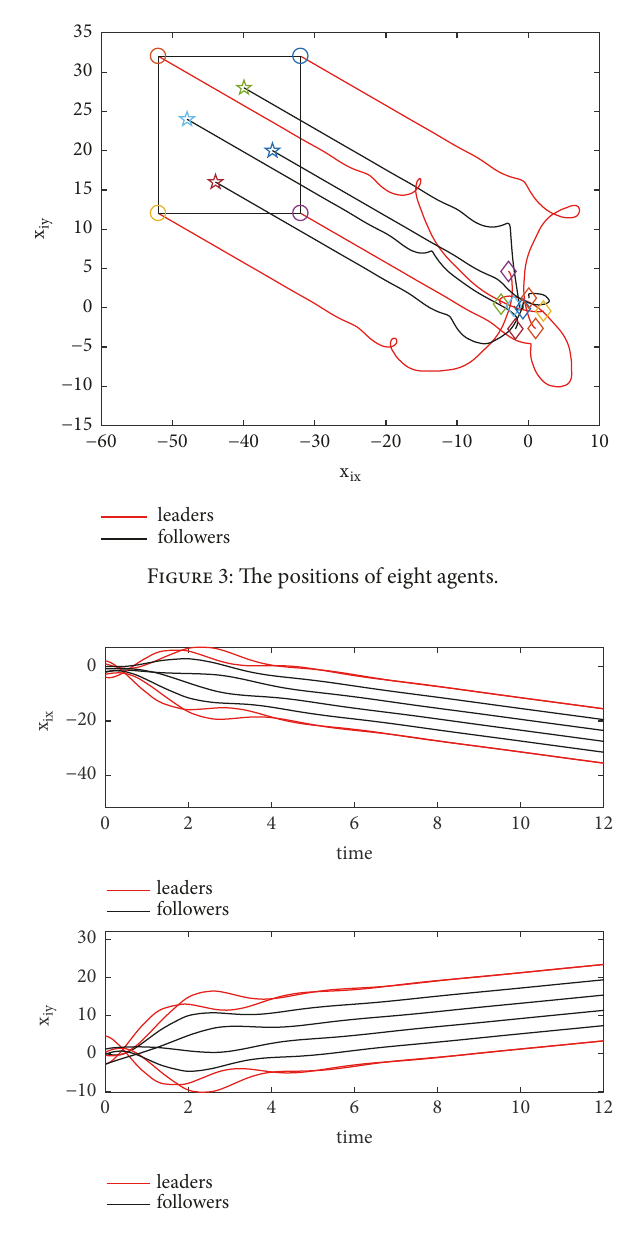
Figure 4: The moving trajectories of eight